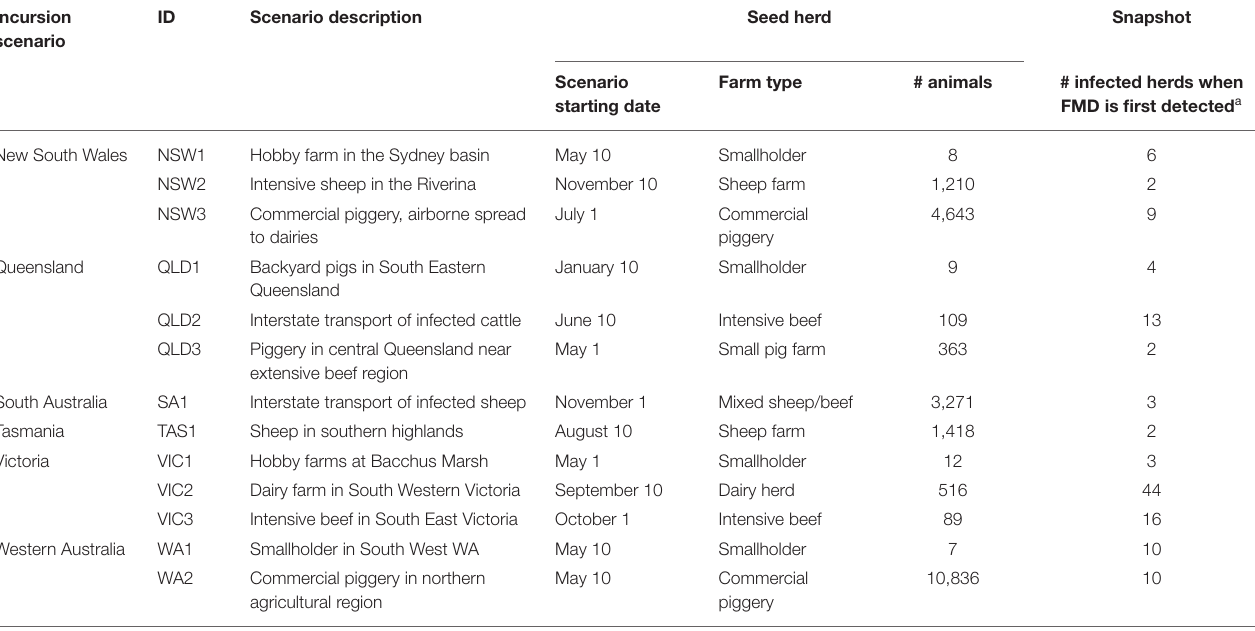
TABLE 2 | Starting conditions for simulation study FMD incursion scenarios: seed herds and